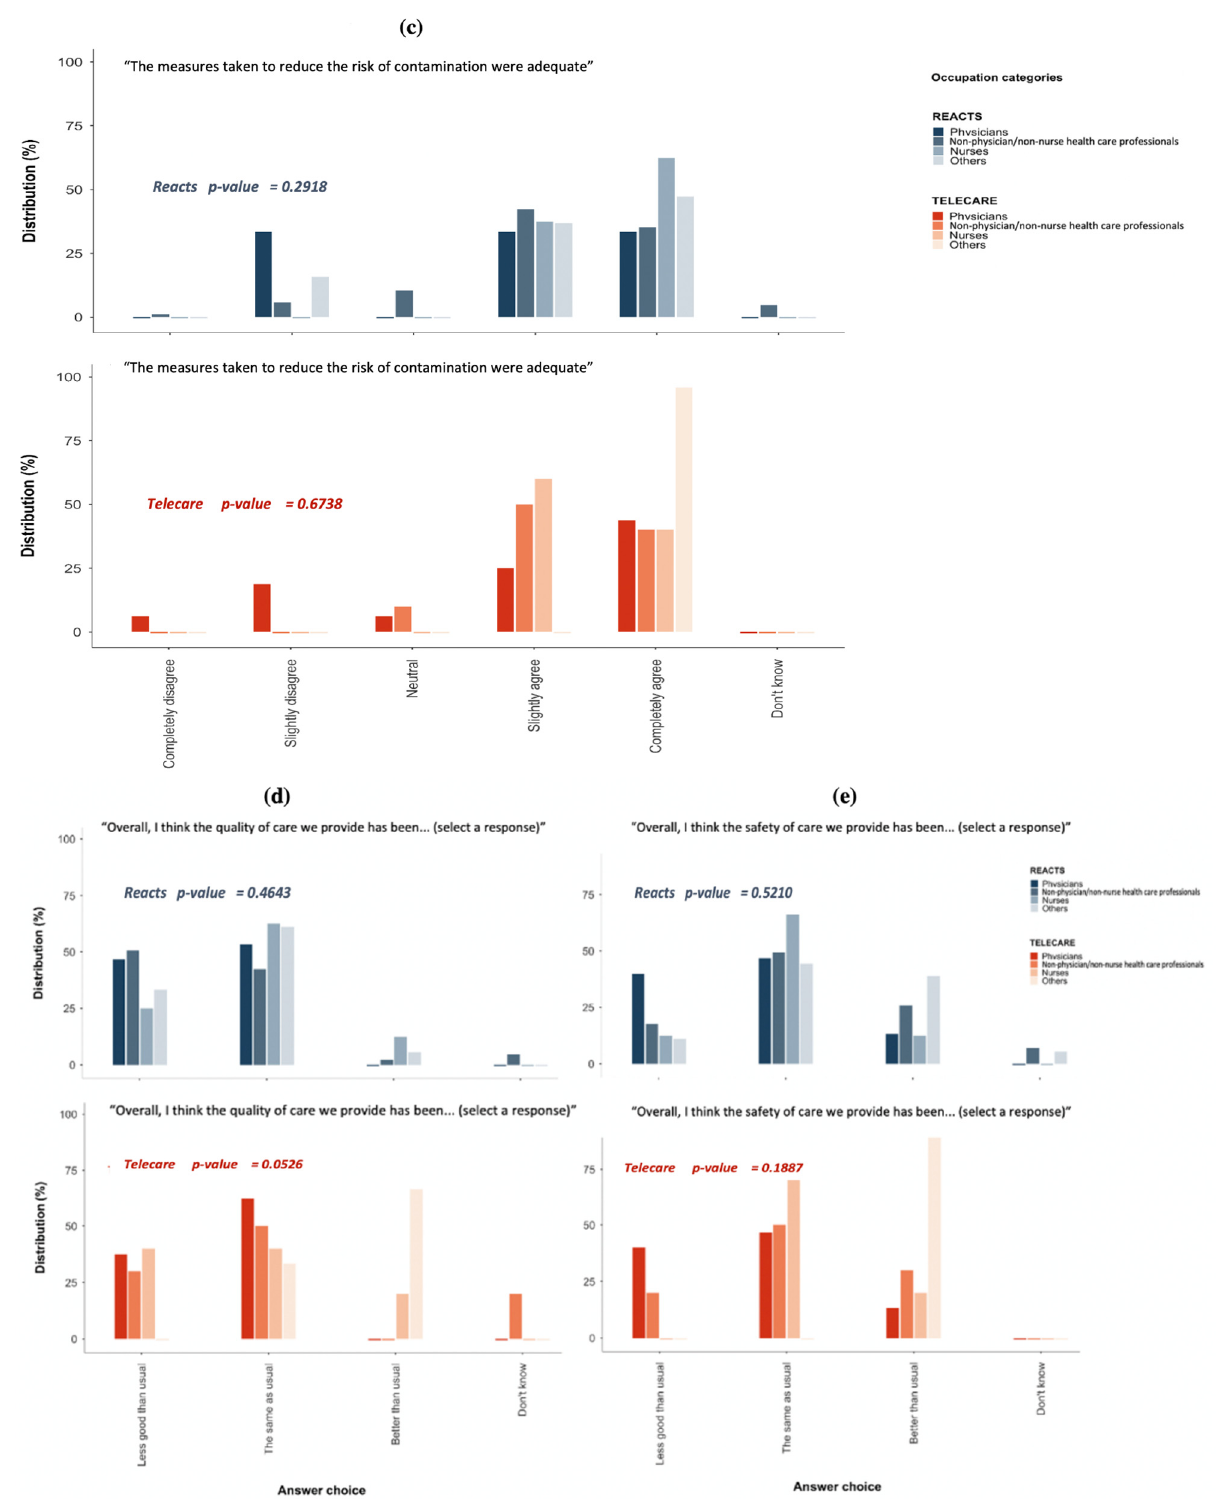
Figure 1. Perceptions of the performance, quality, and safety of care. ( a ) Respondents’ perception of sense of work provided on REACTS platform vs. TELECARE Platform; ( b ) Respondents’ perception of work environment and performance provided on REACTS platform vs. TELECARE Platform Figure 1; ( c ) Respondents’ perception of reducing contamination measures provided on REACTS platform vs. TELECARE Platform; ( d ) Respondents’ perception of quality of care provided on REACTS platform vs. TELECARE Platform; ( e ). Respondents’ perception of safety of care provided on REACTS platform vs. TELECARE